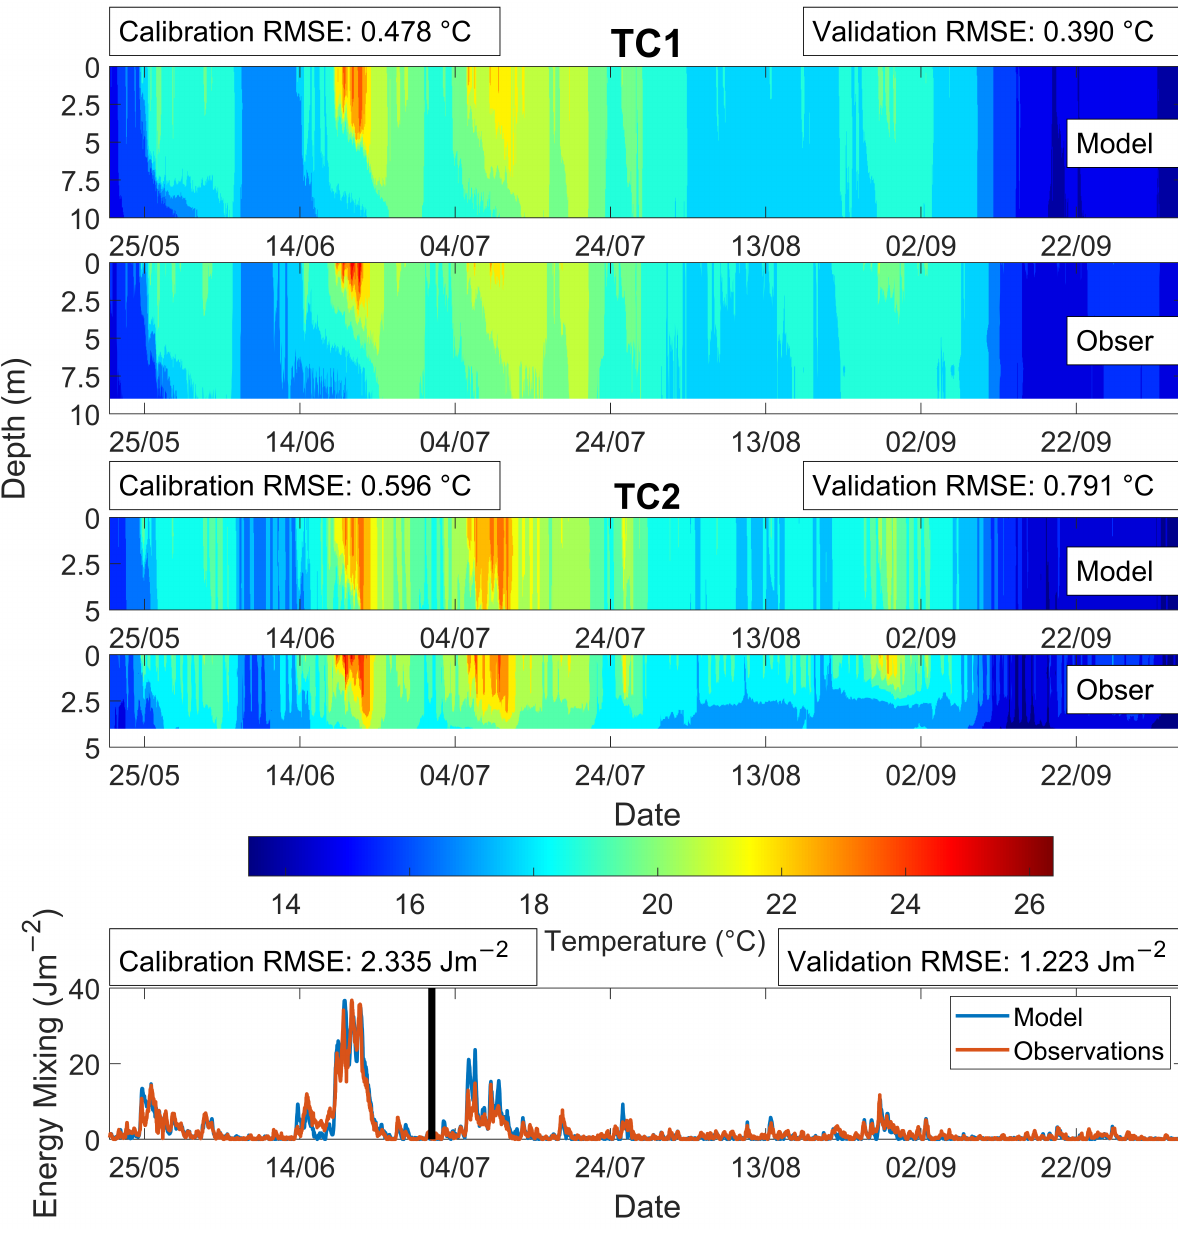
Figure 6. Assessment of model performance. Contour plots show comparisons between modelled results and observations for temperature ( top panels). Also shown is a plot of Schmidt stability ( S ) over time between the observed and modelled runs ( bottom panel). RMSE between these observations and model data is also shown. Calibration and validation periods are separated by a vertical black